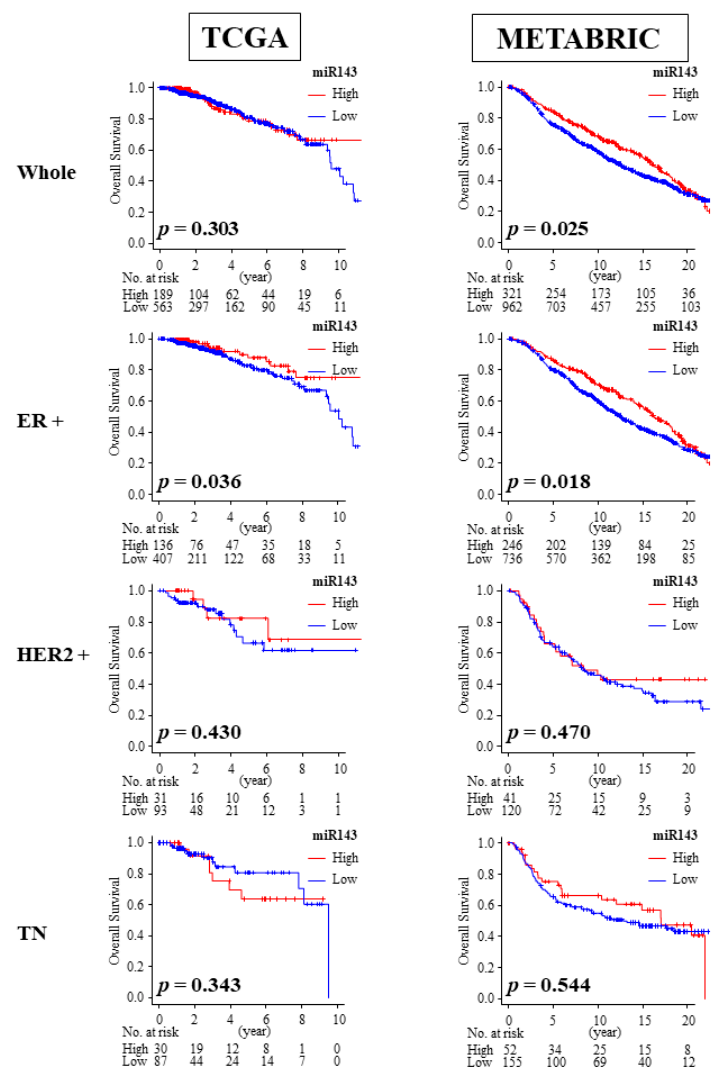
Figure 5. Overall survival (OS) of miR-143 high expression group and miR-143 low expression group in TCGA and METABRIC. Only ER positive subgroup demonstrated improved OS. ER+, estrogen receptor positive; HER2, human epidermal growth factor receptor 2; TN, triple negative.